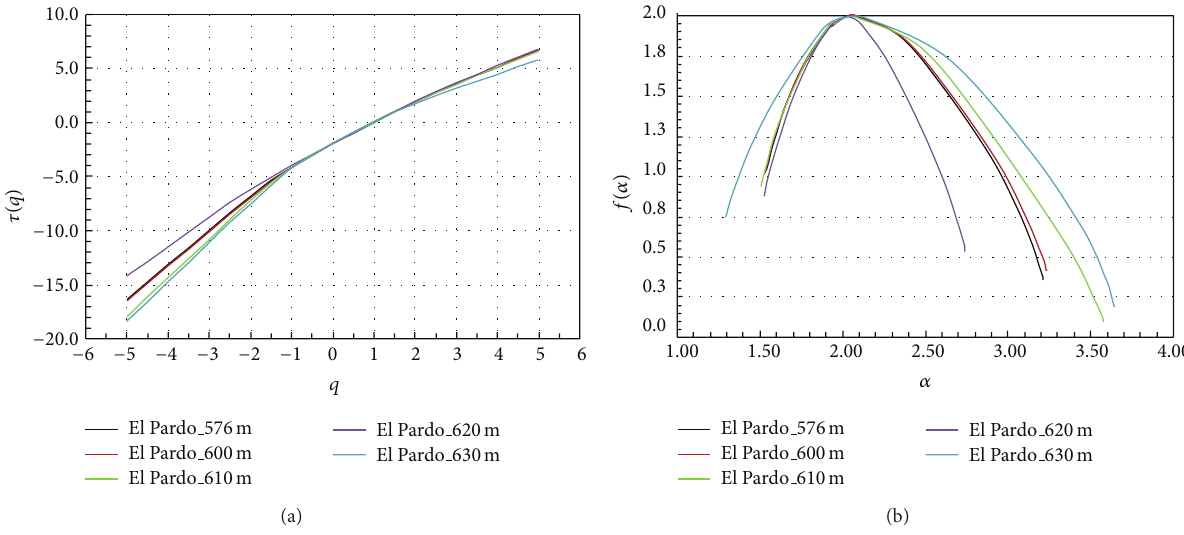
Figure 6: (a) Mass exponent function ( 𝜏(𝑞) versus 𝑞 ) and (b) multifractal spectrum ( 𝑓(𝛼) versus 𝛼 ) based on absolute gradient. Each colour represents the water reservoir at different filling levels.